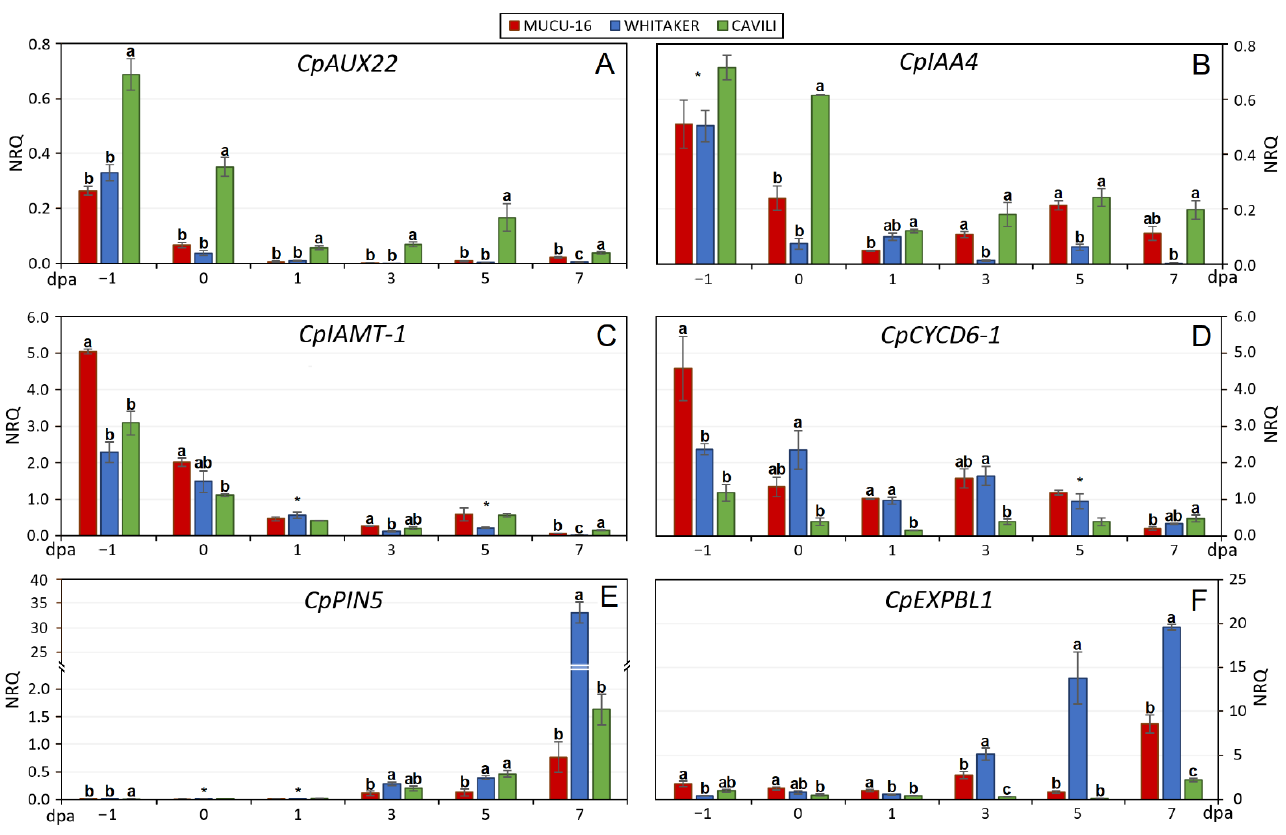
Figure 3. Normalized relative quantities (NRQ) in non-treated samples. Data represents the NRQ for genotypes MUCU-16 (red), Whitaker (blue) and Cavili (green) and days post anthesis − 1, 0, 1, 3, 5 and 7 in each gen: ( A ), CpAUX22 (auxin-induced protein AUX22-like); ( B ), CpIAA4 (auxin-responsive protein IAA4-like); ( C ), CpIAMT-1 (indole-3-acetate O-methyltransferase 1-like); ( D ), CpPIN5 (auxin efflux carrier PIN-FORMED 5-like); ( E ), CpCYCD6-1 (cyclin D6-1-like); ( F ), CpEXPLB1 (expansin-like B1). Significative differences (ANOVA, p < 0.05) are indicated with letters (Tukey HSD). * No significative differences. Error bars are standard errors (n = 3).